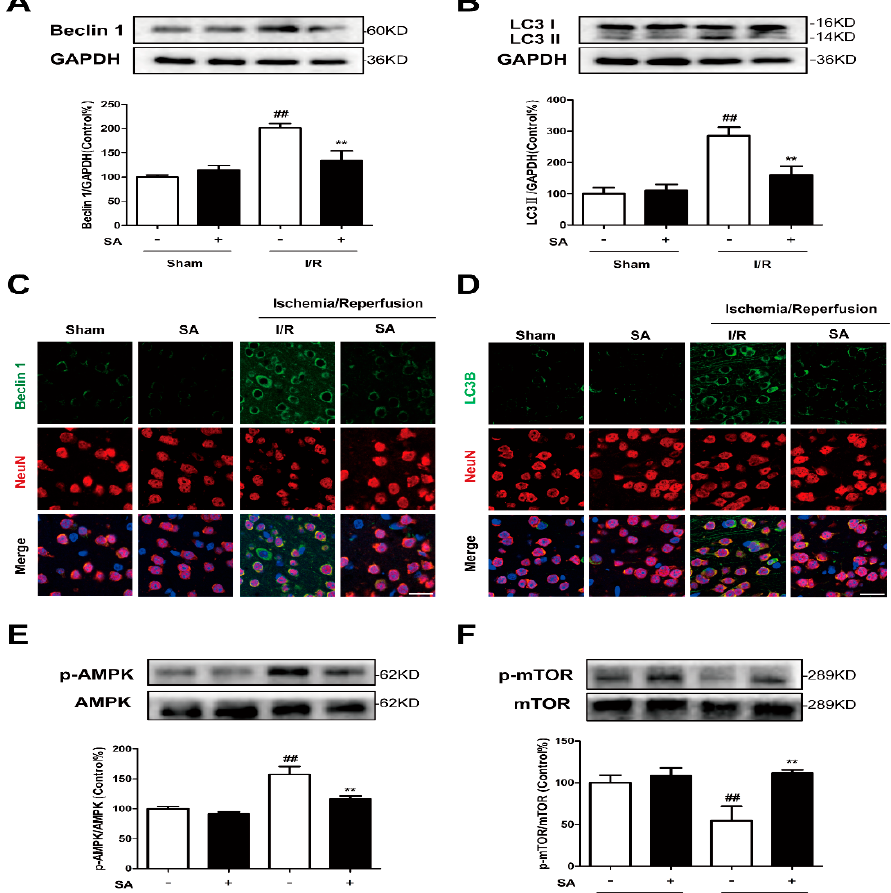
Figure 7. SA Inhibits AMPK/mTOR Pathway and Autophagy Following Cerebral Ischemia/Reperfusion Injury in Mice. Mice were pretreated with SA and exposed to I/R. ( A , B ) The expression of Beclin 1 ( A ) and LC3 ( B ) was detected by Western blot (n = 3). ( C , D ) Then confocal microscope was used to detect Beclin 1/LC3B (green) and Neun (red). Bar: 20 μ m. ( E , F ) The expression of phosphorylation of AMPK (E) and mTOR (F) was detected by Western blot (n = 3). All data are mean ± SD. ## P < 0.01 vs. Sham group; ** P < 0.01 vs. I/R group.